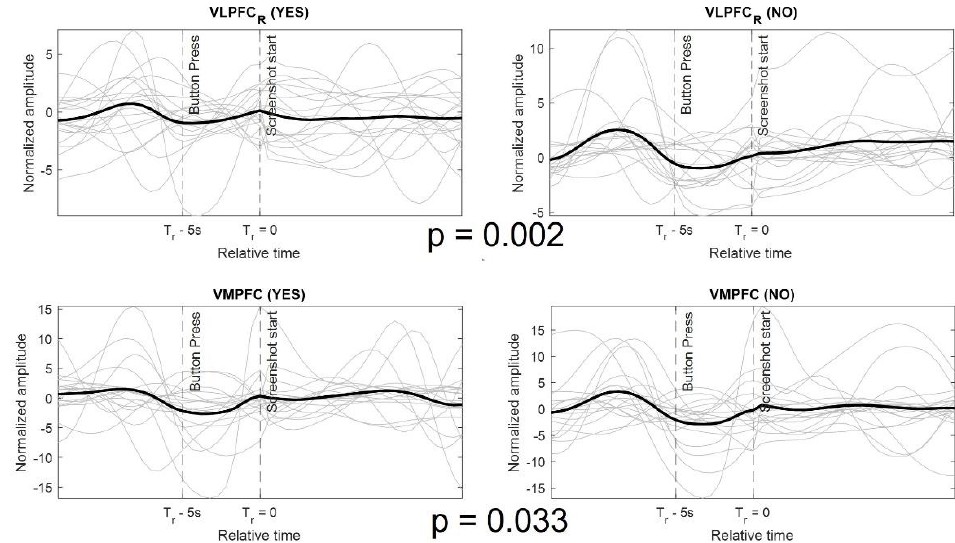
Figure 5. Difference in the pseudo-stimulus for ‘yes’ ( left column ) and ‘no’ ( right column ) download decisions by the participants. The temporal response is shown for voxels in two regions that show a statistically significant difference between the ‘yes’ and ‘no’ apps. The p -values for the paired t test are shown between the subplots. The color coding of the plots is same as in Figure 4.